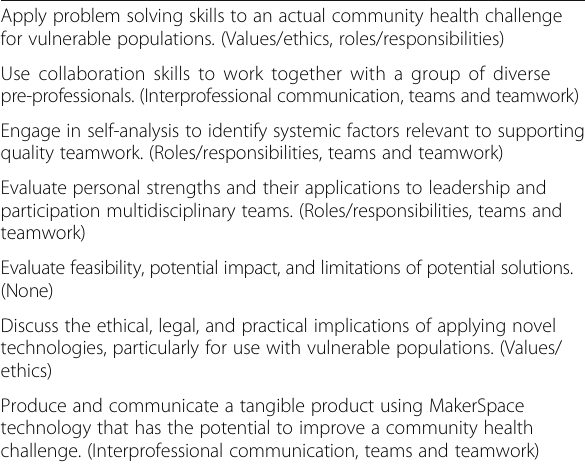
Table 1 Table of course level objectives and the corresponding Interprofessional Education Collaborative (IPEC) competency they align with in